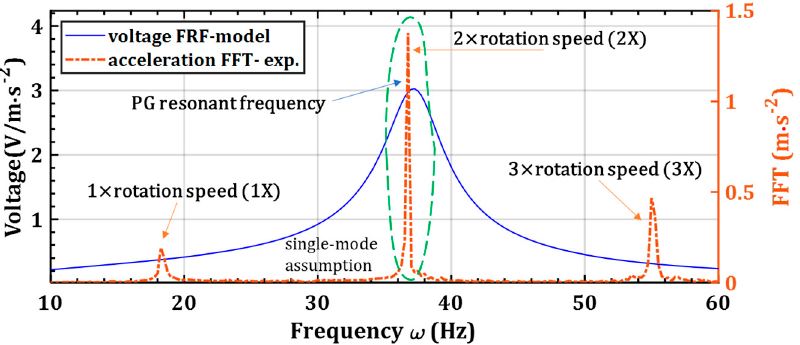
Figure 6. The PG’s voltage response and acceleration FFT, noting the narrow band for these signals, the voltage resonant frequency, and the 2X frequency of the acceleration FFT.